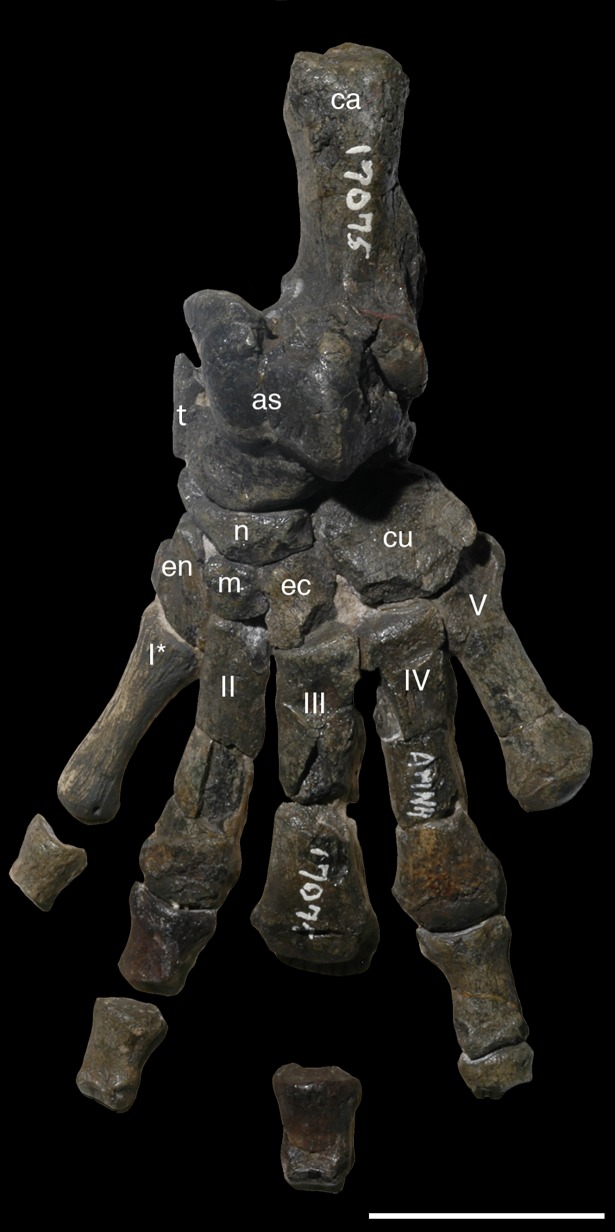
Left pes of Periptychus carinidens (AMNH 17075) in dorsal view.Abbreviations: as, astragalus; ca, calcaneum; cu, cuboid, ec, ectocuneiform; en, entocuneiform; m, mesocuneiform; n, navicular; t, tibiale; I-V refer to digit number; * denotes reconstructed elements. Scale bar: 30mm. Note that this specimen is reconstructed and mounted on a resin base. Photographs of the individual bones are illustrated and photographed in [5].